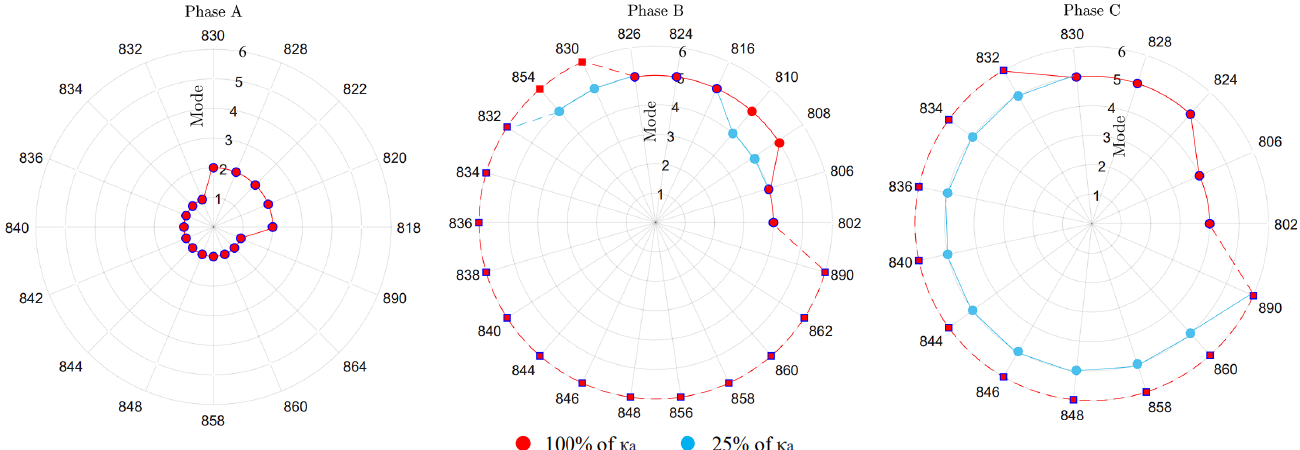
Figure 11. Operation modes using the proposed method for single-phase fault in phase